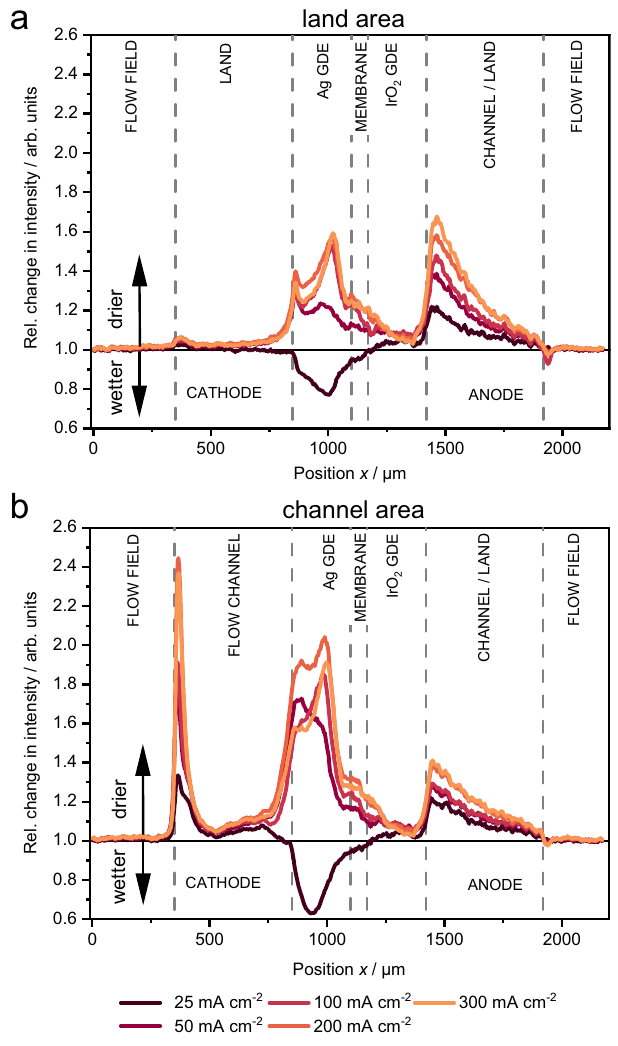
Fig. 5 | Comparison of channel and land area. Relative change in intensity at different current densities compared to open circuit in a cathode fl ow fi eld land area, and b cathode fl ow fi eld channel area. A value larger than one indicates less water/KHCO 3 and a value below one more water/KHCO 3 , as compared to the zero current reference. See Supplementary Fig. 5 for selected regions. Source data are provided as a Source Data fi